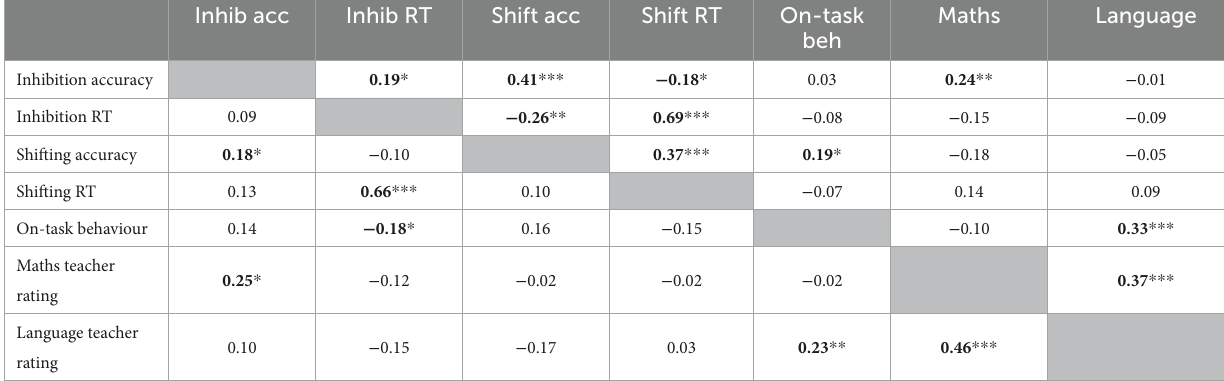
TABLE 2 Spearman correlations and partial correlations of measures of inhibition with observed task-related behaviour and academic achievement.